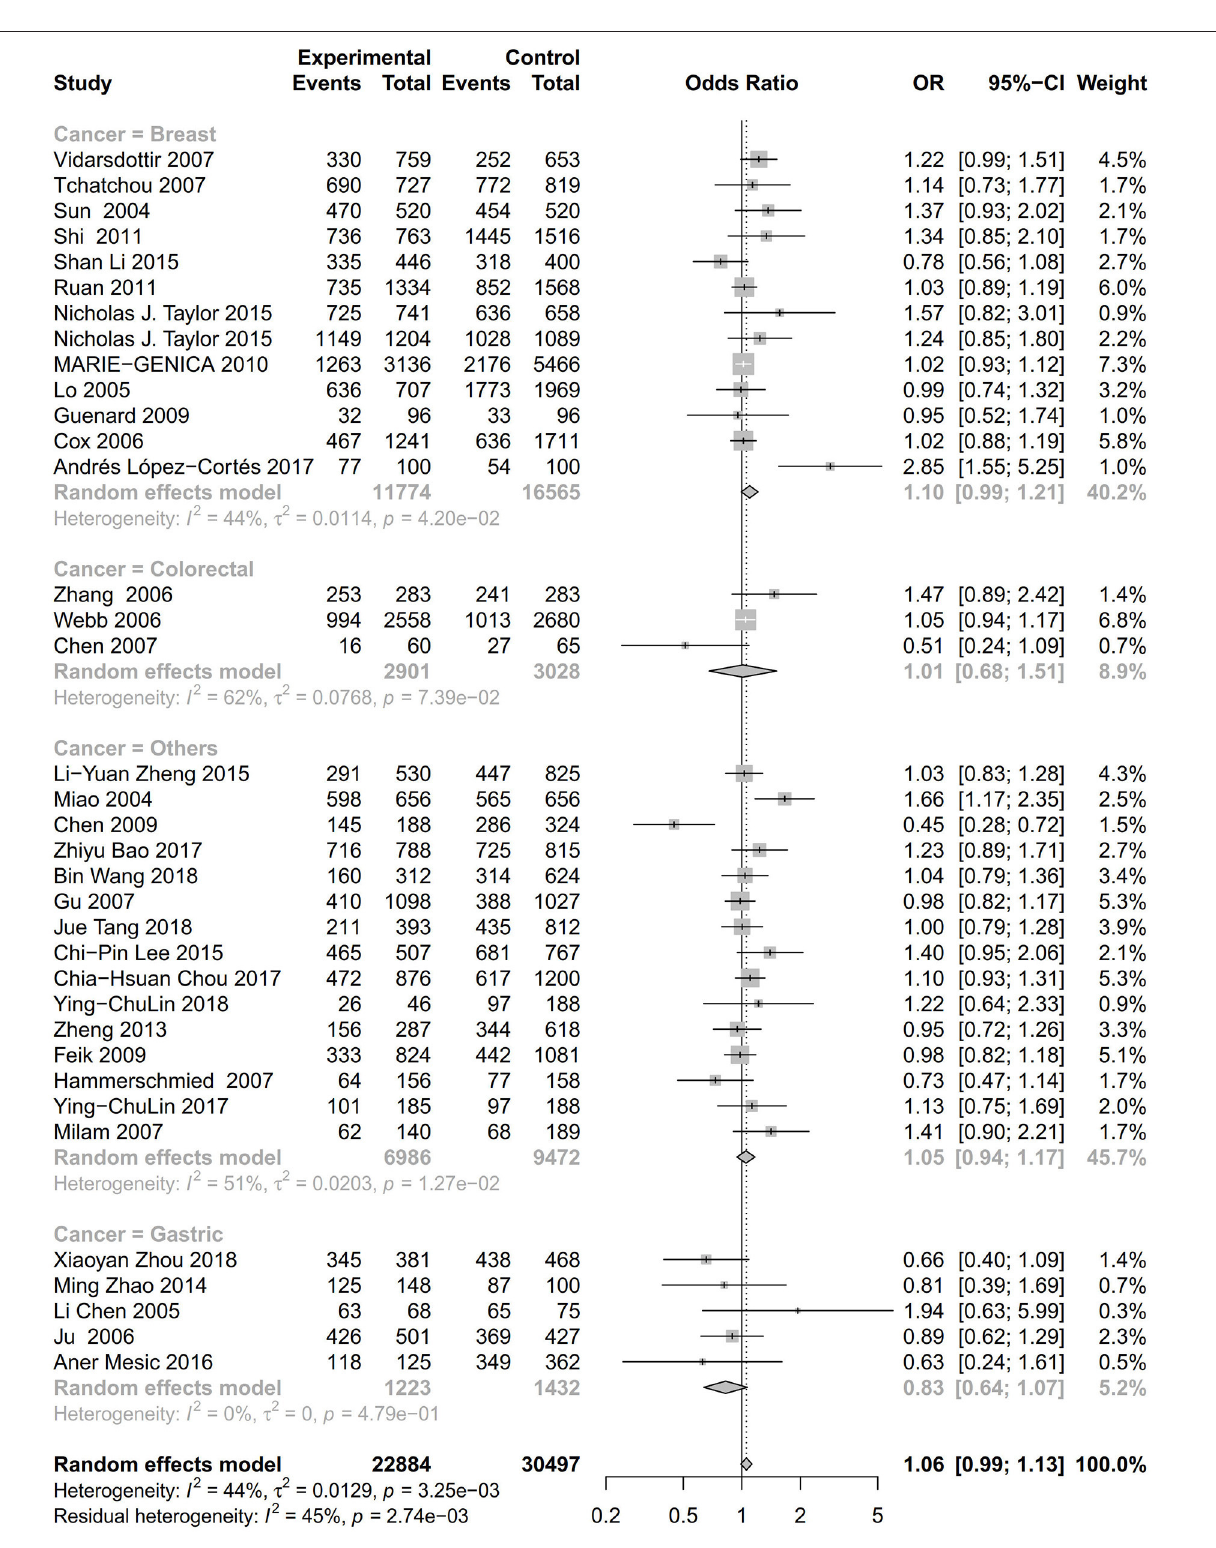
FIGURE 4 | Stratification analysis of the association between the AURKA rs2273535 T > A polymorphism and cancer risk by cancer type under the dominant model (AT + AA vs. TT).